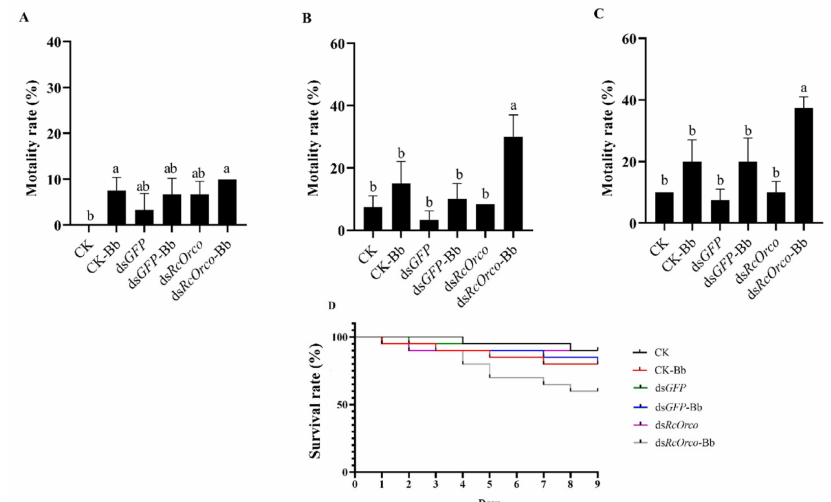
Figure 6. Bioassay of dsRcOrco combined with Bb in R. chinensis . ( A ) Mortality rate of each treatment group at 3 d. ( B ) Mortality rate of each treatment group at 6 d. ( C ) Mortality rate of each treatment group at 9 d. ( D ) Survival rate of each treatment group. The letters above the columns indicate different expressive